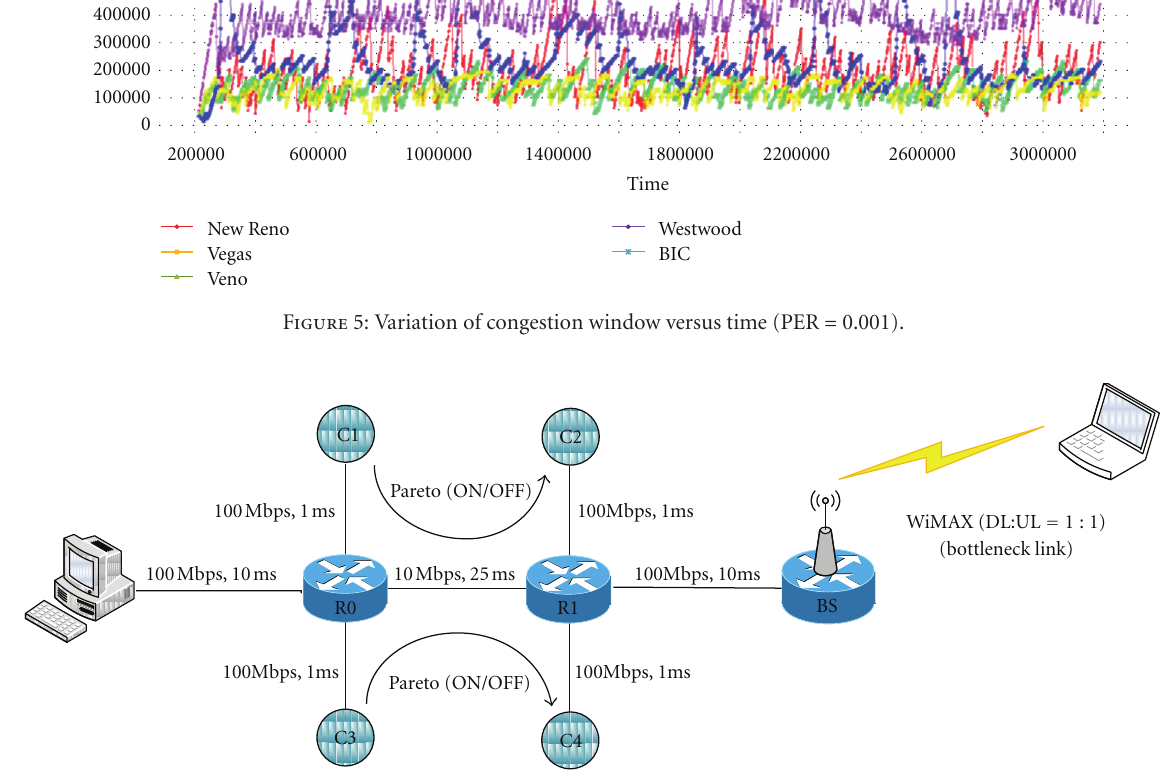
Figure 6: A single TCP flow in a heterogeneous WiMAX network.